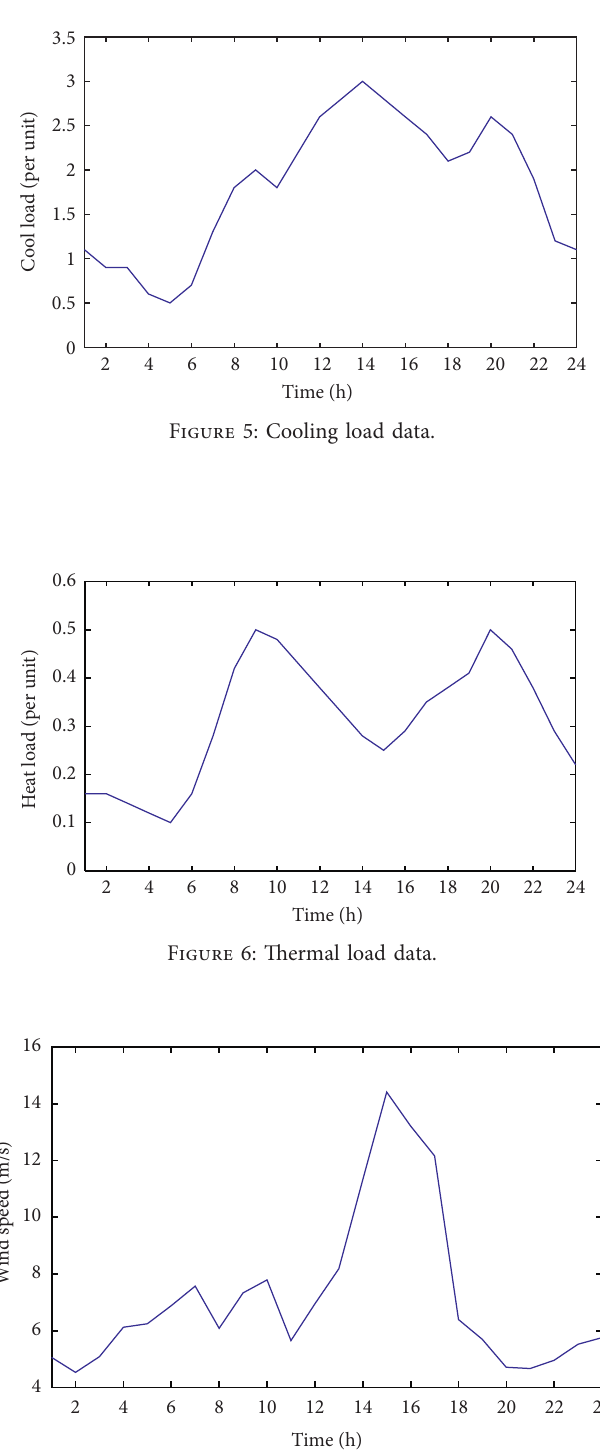
Figure 7: Wind resource data.